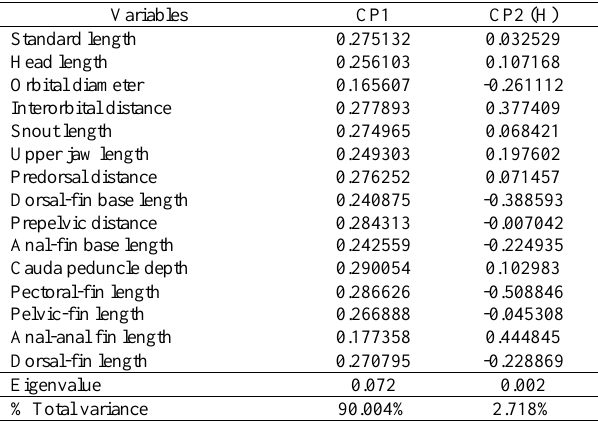
Table 2 . Morphometry of two populations of Astyanax aff. scabripinnis from Ribeirão Grande River, at município